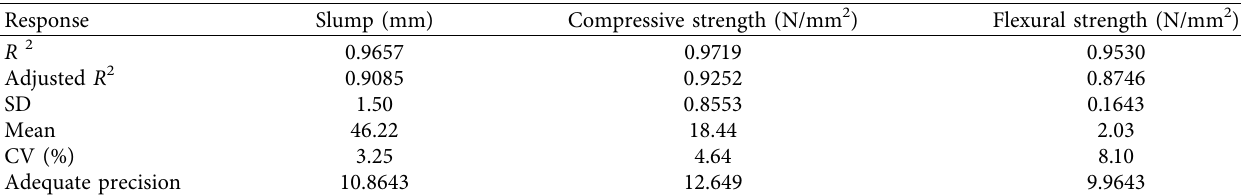
Table 5: Summary of ANOVA results of